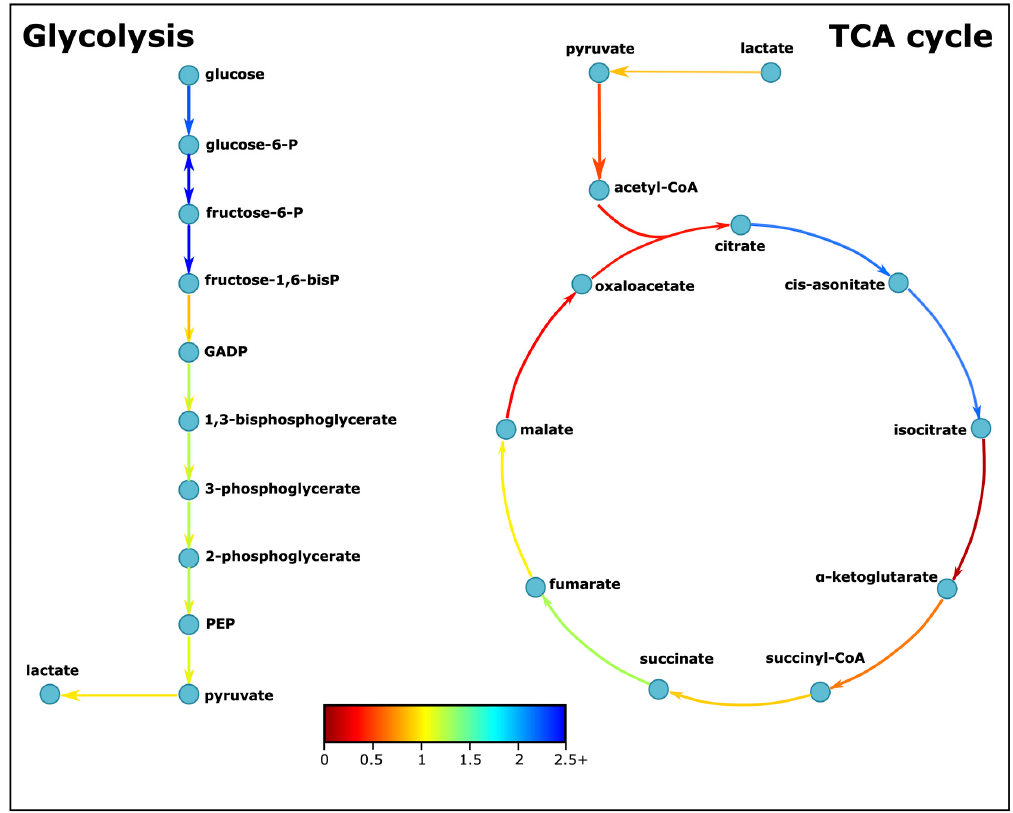
Figure 3. Simplified glycolysis and tricarboxylic acid cycle pathways. The colors indicate the ratio of average fluxes of ASD to control model. GADP: Glyceraldehyde-3-P, PEP: Phosphoenolpyruvate. The disturbance of the TCA cycle reduces the aerobic respiration rate, and this phe- nomenon generally results in elevated levels of pyruvate, as well as its derivatives, lactate and alanine [16]. In our metabolic brain model, the secretion of pyruvate is found to be significantly greater in the ASD model and lactate is found to be generally transferred into the cell, yet the ASD model needed less lactate than the control model. Pyruvate is con- verted to alanine by alanine aminotransferase (ALT), whereas the pyruvate-derivative ox- aloacetate is converted to aspartate by the aspartate aminotransferase (AST) enzyme. Our simulations show that pyruvate secretion and the activity of reactions catalyzed by ALT and AST are higher in the ASD model, thus supporting the reduced aerobic respiration hypothesis (Figure 4). Several studies also revealed elevated ALT and AST levels in the bodily fluids of ASD patients [51], confirming our results. The disturbances in the TCA cycle may also be explained by the elevated levels of ammonia in the cell, which is a by- product of protein metabolism and is accepted as another biomarker of the mitochondrial disorder [52–54]. Our results showed that the ASD model secretes higher ammonia on average (Figure 4). Elevated ammonia levels may constrain the TCA cycle in neurons and glia by inhibiting cycle enzymes such as pyruvate dehydrogenase (PDH), isocitrate dehy- drogenase, (IDH), and α -ketoglutarate dehydrogenase ( α -KGDH).